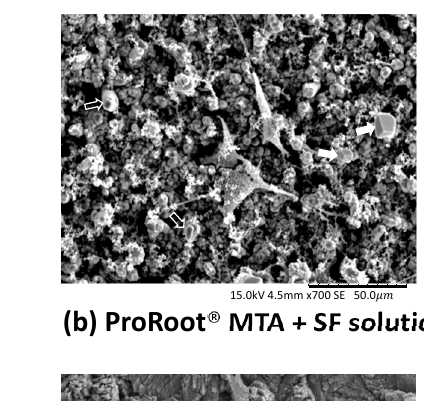
Figure 3. MG-63 osteoblast-like ( a ) cell cytotoxicity and ( b ) cell proliferation of ProRoot ® white MTA and SavDen ® MTA individually set with deionized water (DDW) and 5 wt% SF solution. Three samples (n = 3) were examined for each data point. * Indicates a significant di ff erence ( p < 0.05).